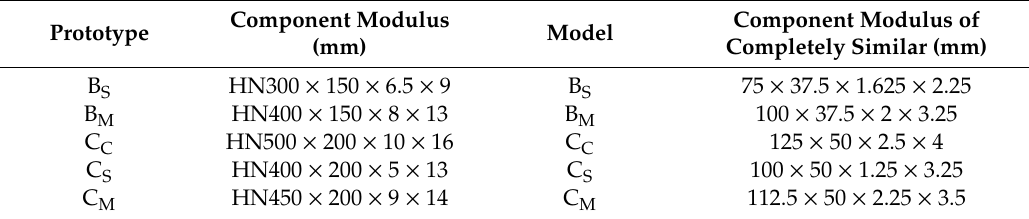
Table 3. Component modulus of completely similar.